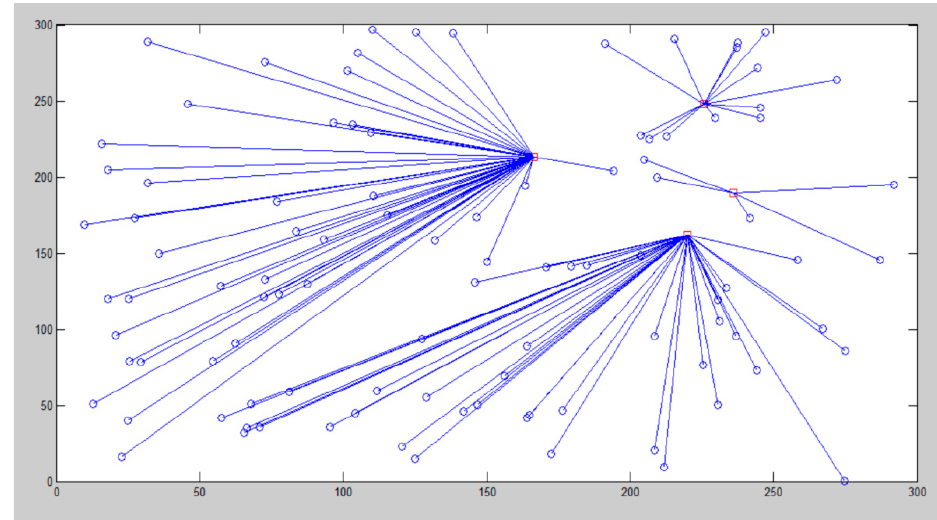
Figure 5. Multi-channel grouping process. Table 5. The proces of forming a WSN channel. Algorithm 4: The process of forming a WSN channel